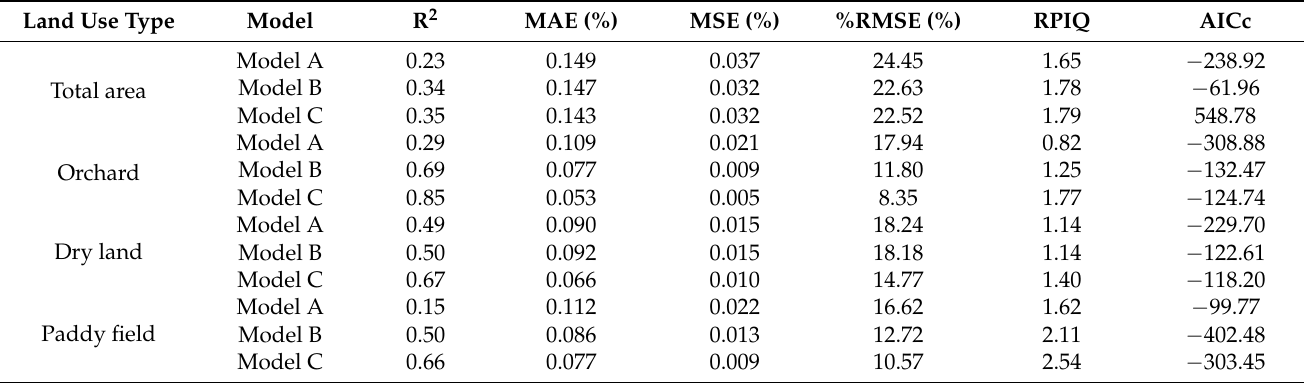
Table 3. Prediction accuracy of models with different input combinations under total area, orchard, dry land, and paddy